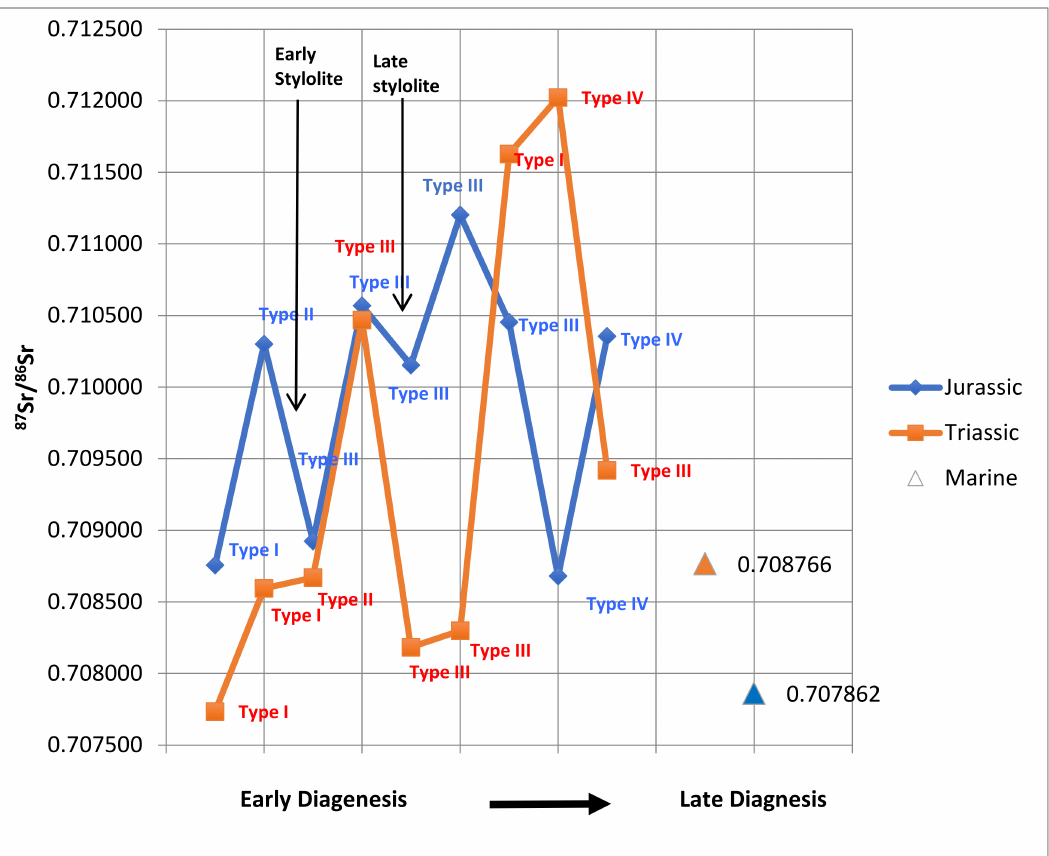
Figure 15. The rate of change of 87 Sr / 86 Sr according to time in order to illustrate the number of jumps between the di ff erent diagenetic conditions in both sections separately. The number of jumps (down and up) can calculate the number of fault reactivation ( n =